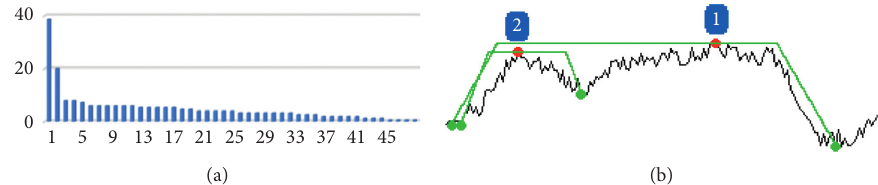
Figure 11: (a) Sorted prominences of Road3 data, where the ratio of the second (the prominence of the last detected peak) to the third (the greatest prominence of the noise) is 250%. (b) The detected peak points (each marked by its prominence ordinal number) and the supporting hills.